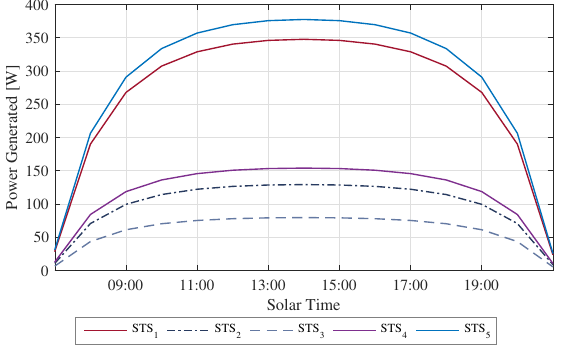
Figure 14. Comparison of the energy generated of the five solar